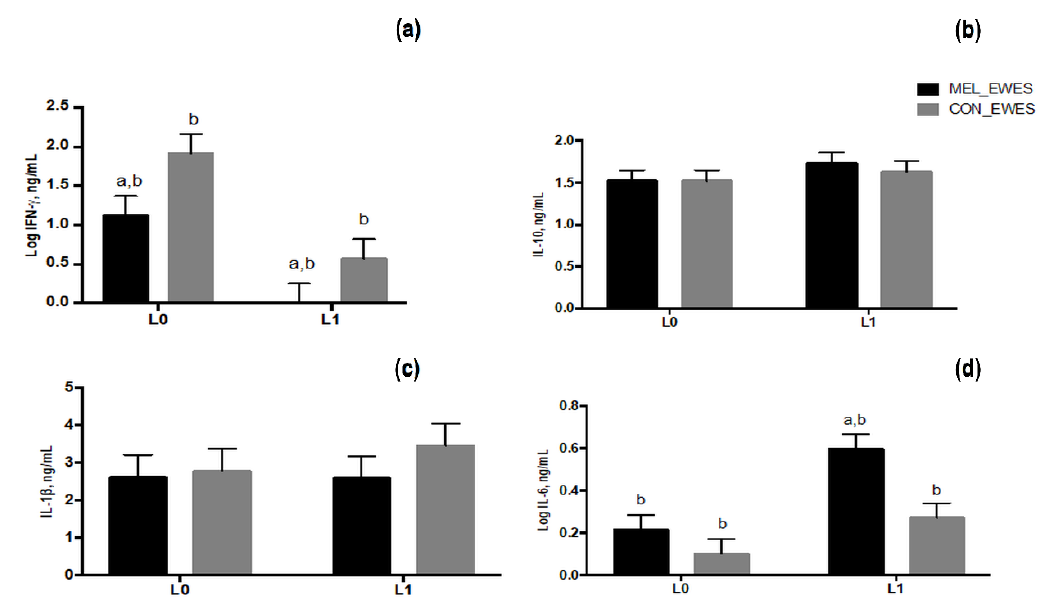
Figure 7. Least squares means ± SEM of levels of plasma IFN- γ ( a ), IL-10 ( b ), IL-1 β ( c ) and IL-6 ( d ) at lambing (L0) and 24 h later (L1) in control ewes (CON) and in melatonin ewes (MEL), p < 0.05, a: among the two groups, b: within time.